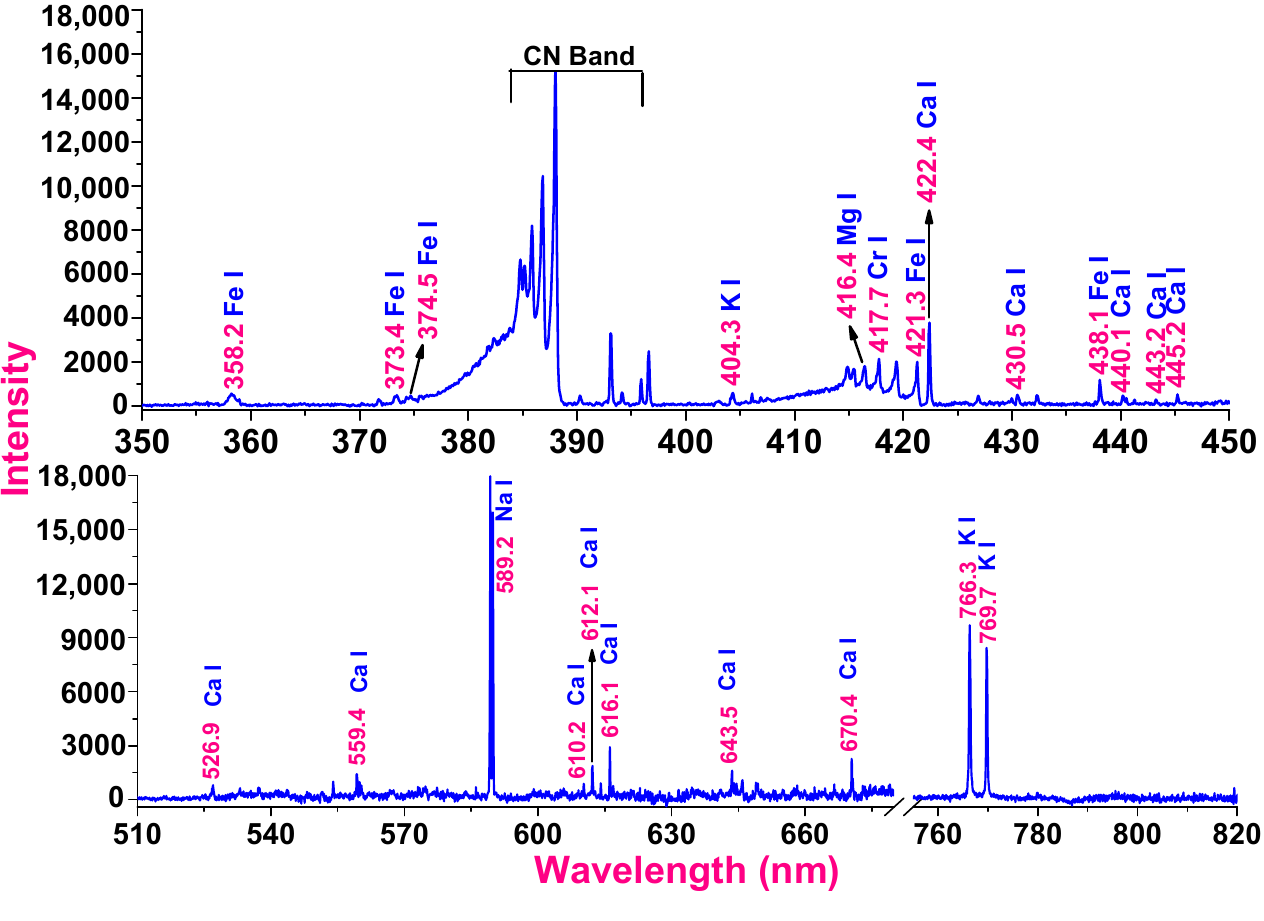
Figure 2. Recorded emission spectrum of the mushroom excited by direct current arc in the spectral region of 350–900 nm.